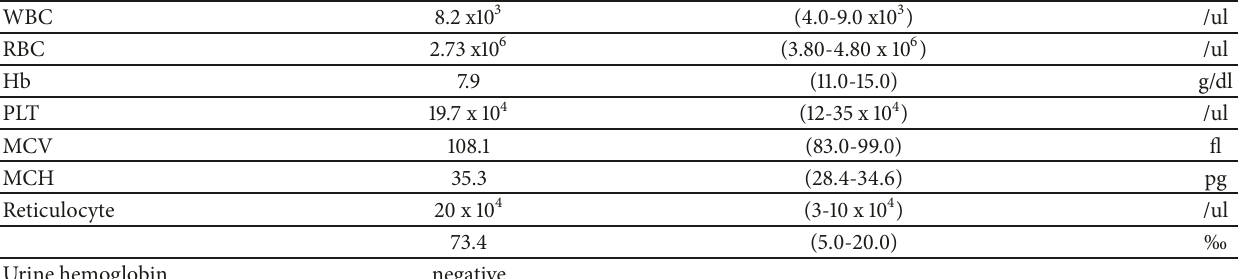
Table 1: Blood test results (reference ranges are